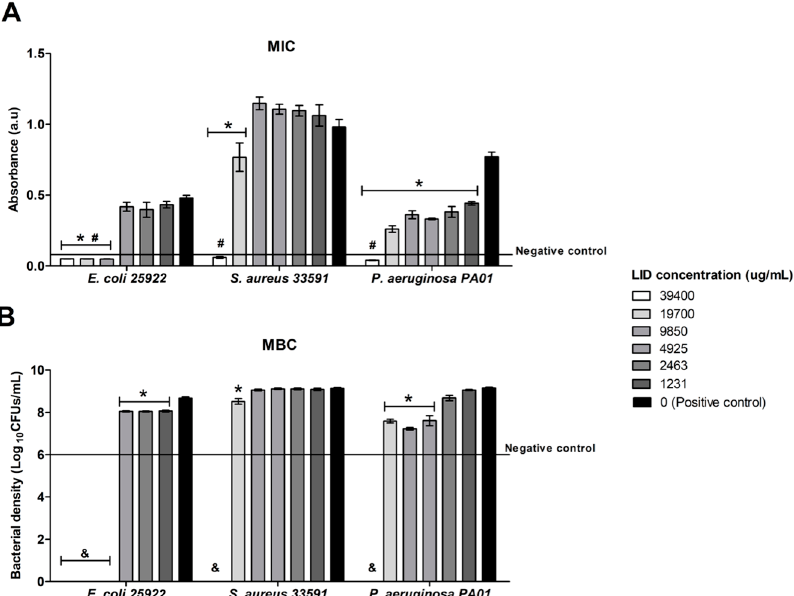
Figure 8. Antimicrobial activity of LID obtained by determination evaluation of minimum inhibitory concentration (MIC) ( A ) and minimum bactericidal concentration (MBC) ( B ) for Escherichia coli 25922, Staphylococcus aureus 33591, and Pseudomonas aeruginosa PA01 strains. *Statistically different ( p < 0.05) compared with bacterial growth without LID (positive control). # Absorbance of bacterial growth lower or equal to the control negative (absorbance of medium without bacteria). & statistically different ( p < 0.05) compared with initial bacterial concentration (negative control MBC).